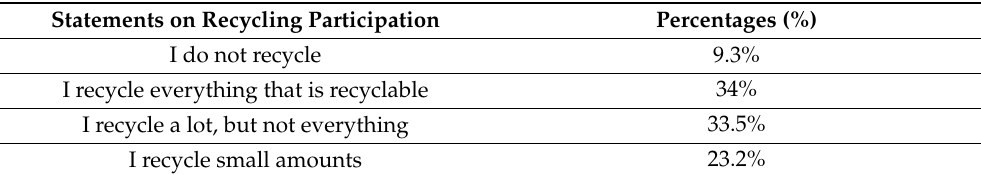
Table 3. Statements on recycling participation rates amongst